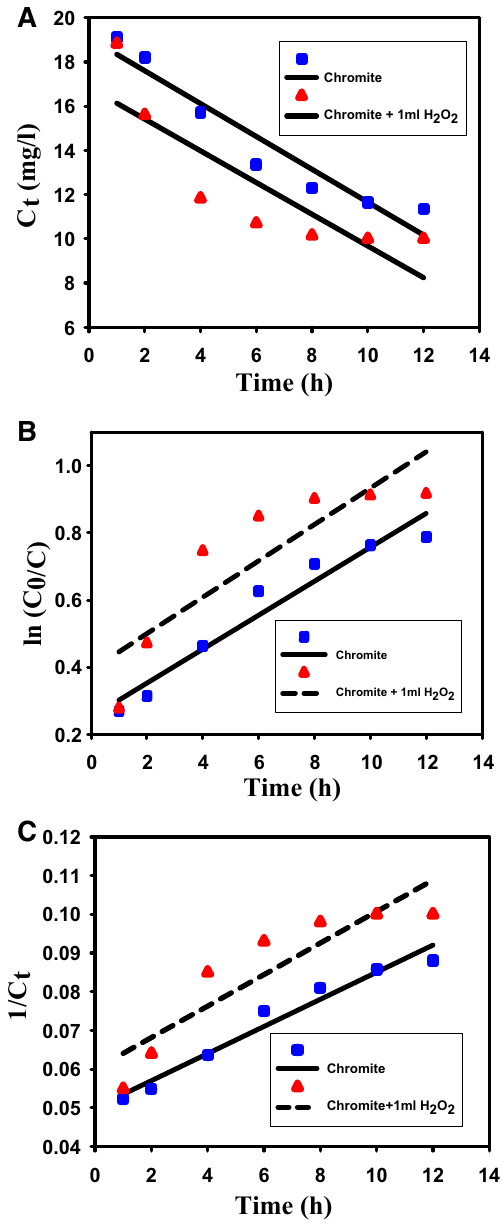
Fig. 4 a Linear relation of zero order kinetic model, b linear relation of the first order kinetic model, c linear relationship of the second order kinetic